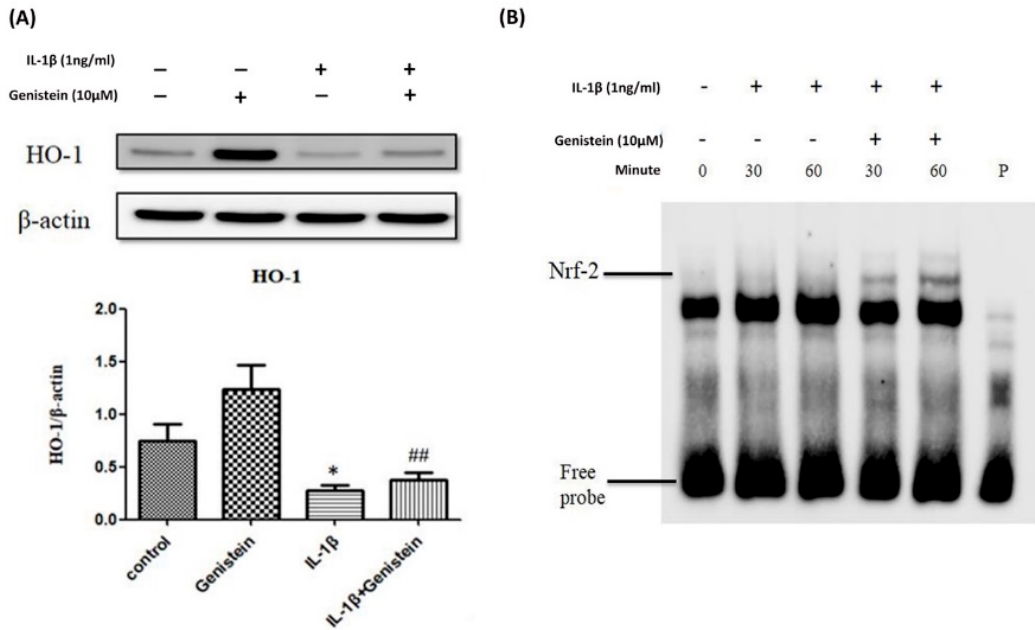
Figure 3. Genistein a ff ected IL-1 β -stimulated Nrf2 / HO-1 signaling pathways in